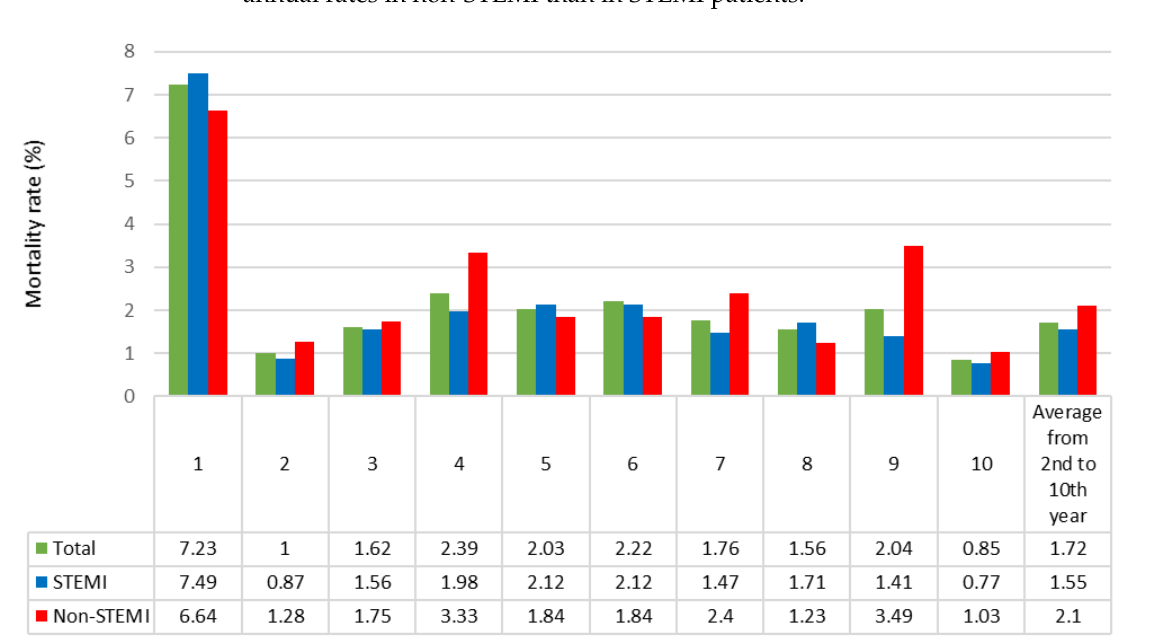
Figure 1. Annual mortality rates during follow-up according to the type of acute coronary